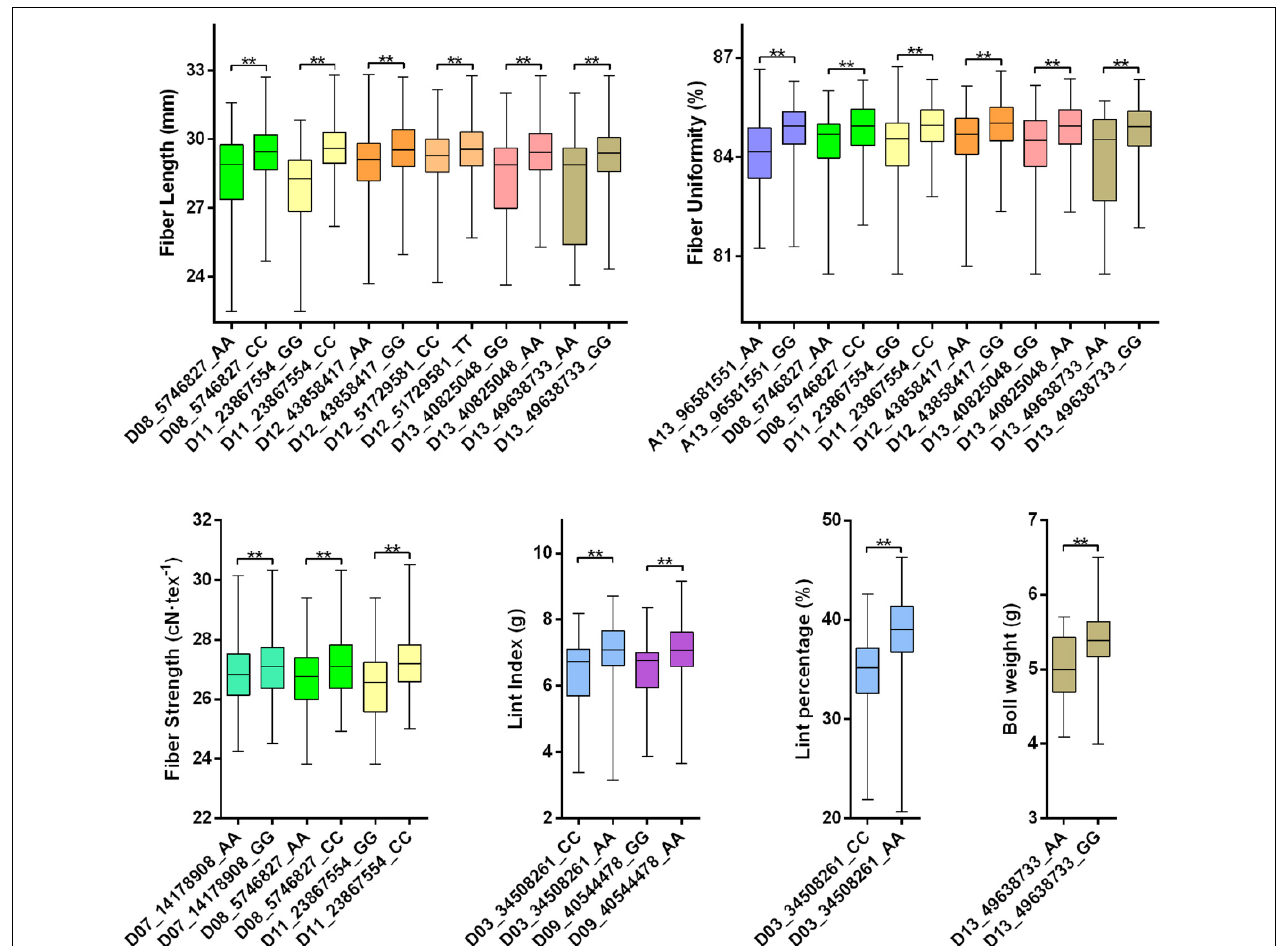
FIGURE 4 | Validation of SNP markers in part of major QTL